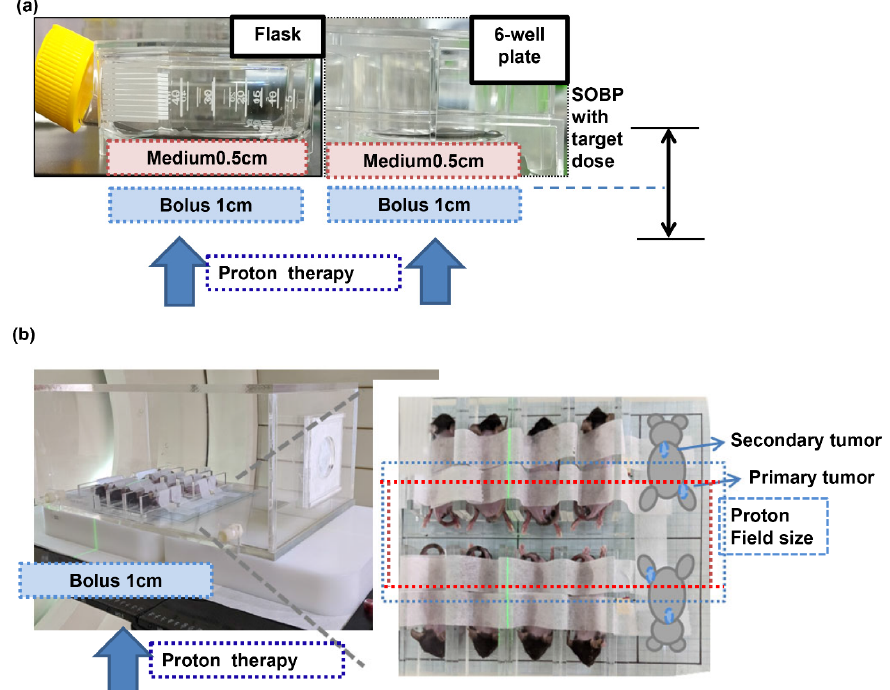
Figure 1. Preclinical model for PT. The experimental proton beam designs for in vitro ( a ) and animal tumor models (RT field for liver tumor irradiation, blue line; RT field to examine abscopal effect, red line) ( b ).